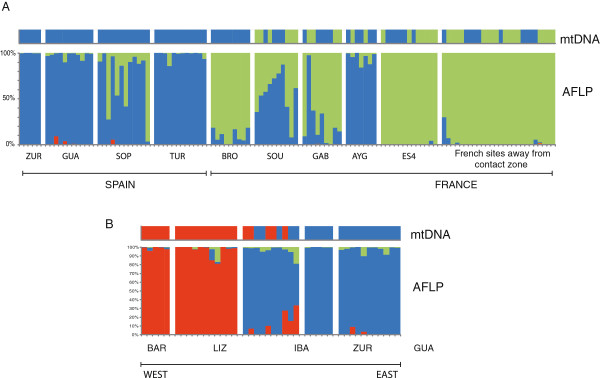
Introgression patterns in mtDNA and AFLP loci at two contact zones among Zootoca vivipara lineages: (A) North–south contact zone between Spain and France; and (B) East–west contact zone between eastern and central Pyrenees. Each plot is divided into an mtDNA block on top and an AFLP block below. Each vertical bar on these blocks corresponds to a single individual in the different sampling sites (abbreviated on the bottom row). For the mtDNA, colors correspond to clades in Figure 2A, and for the AFLP data each vertical bar corresponds to the percent assignment probability to genetic clusters on Figure 2B.